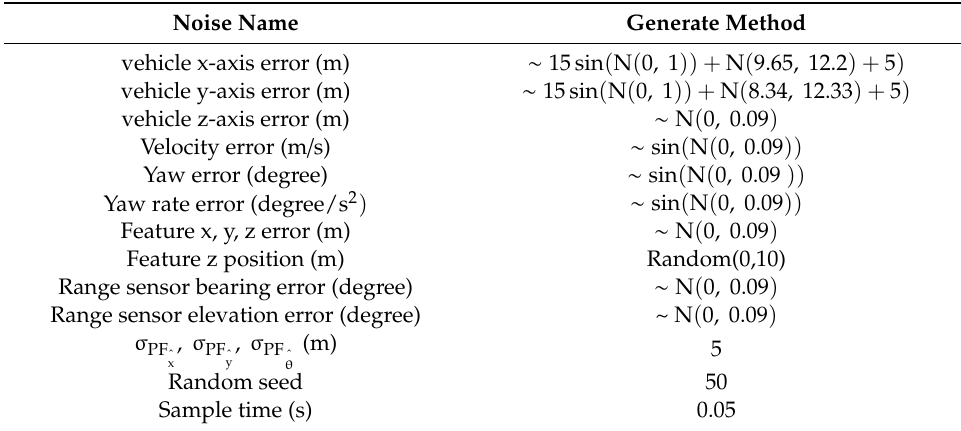
Figure 3. ( a ) Maximum perception range; ( b ) randomly generated 3D feature along the road. Table 2. Simulation environment